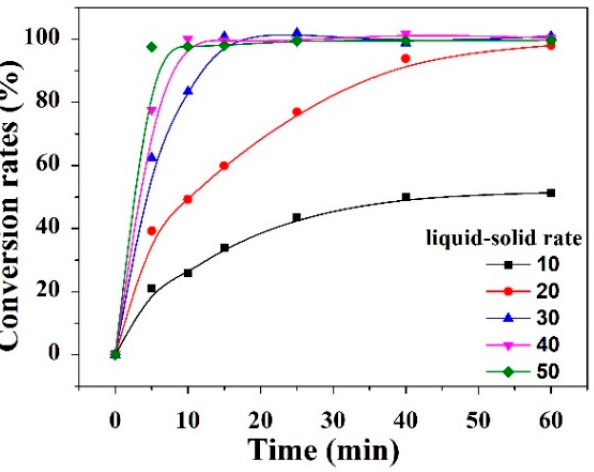
Figure 4. Effect of liquid-solid ratio on carbonization reaction [temperature = 25 °C, flow rate of CO 2 = 3 L/min].